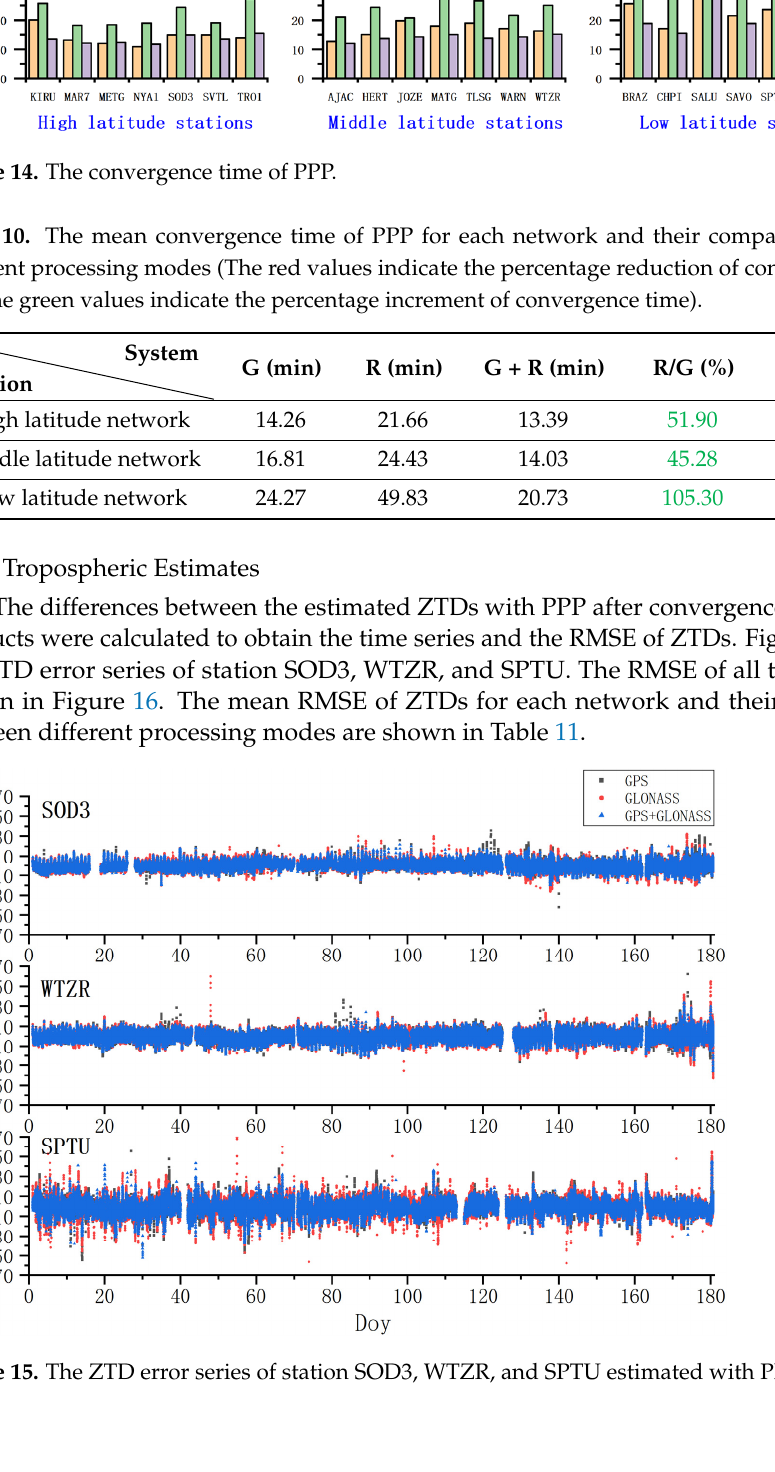
Figure 15. The ZTD error series of station SOD3, WTZR, and SPTU estimated with PPP.